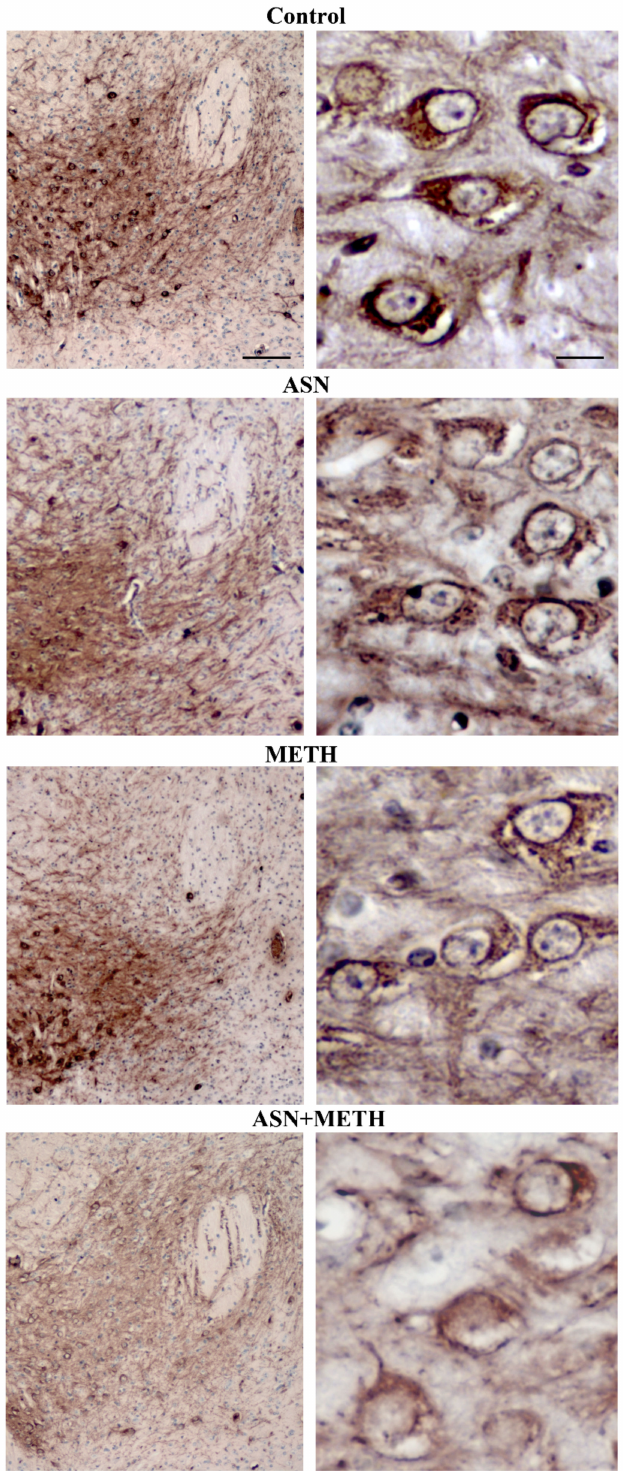
Figure 9. Representative pictures of TH-immunopositive cell bodies within VTA. Combined treat- ment with ASN and METH affects the cell body of TH-immunopositive neurons within VTA. Scale bar (low magnification) = 100 µ m; scale bar (high magnification) = 12 µ m. Remarkably, the decrease of TH immunohistochemistry within SNpc and VTA, which occurs following combined ASN + METH-administration is accompanied by an increase in glial fibrillary acidic protein (GFAP) immunostaining (representative pictures of Figure